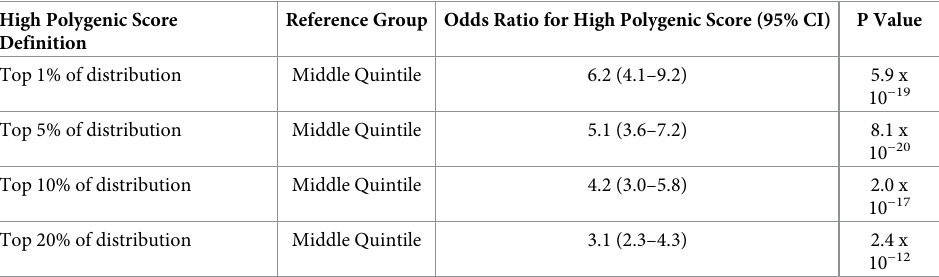
Table 1. Association of High Polygenic Score with Alzheimer’s Disease in the UK Biobank.